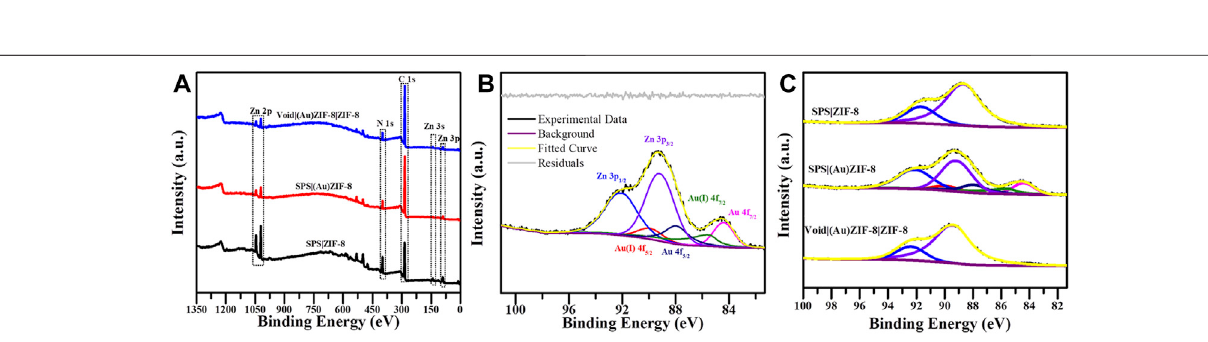
Frontiers in Chemistry |